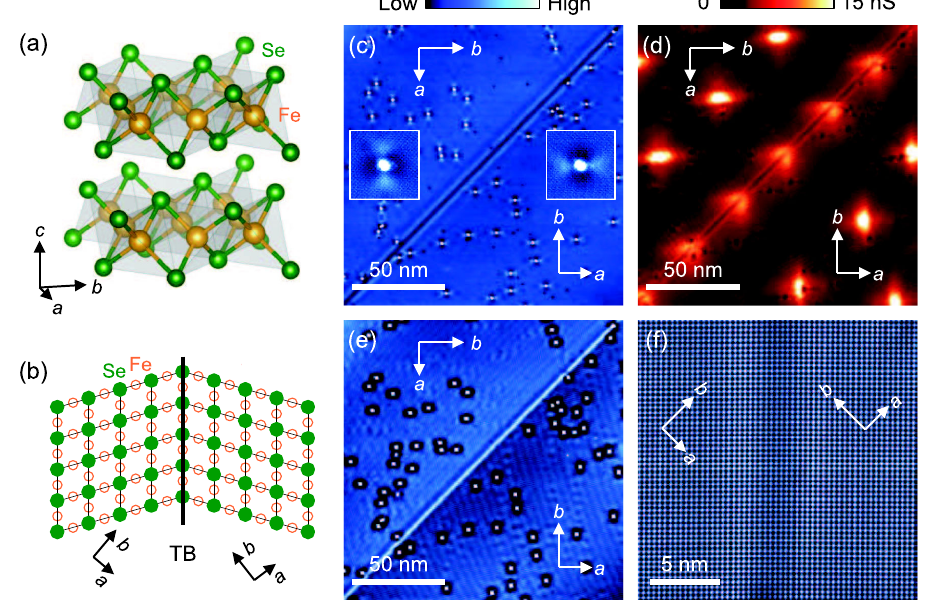
FIG. 1. (a) Crystal structure of FeSe visualized using the VESTA program [18]. (b) Schematic top view of the atomic arrangement near the TB of FeSe (not in scale). Green filled circles and orange open circles denote topmost Se and Fe atoms, respectively. Se atoms beneath the Fe layer are not shown. (c) A constant-current STM image of the cleaved (001) surface of FeSe at 1.5 K showing the TB running from bottom left to top right. Crystallographic axes parallel to the Fe-Fe direction are shown by white arrows ( b > a ). The two insets show a magnified image of the defect ( 8 . 8 × 8 . 8 nm 2 ) in the upper-left or lower-right domain. Note that the pattern is rotated by π = 2 between the two domains. The setup conditions for imaging are V 95 mV and I 10 pA. (d) Zero-bias conductance image s ¼ þ t ¼ 10 mV and g ð r ; E ¼ 0 Þ at 1.5 K showing vortices. A magnetic field of 1 T is applied along the c axis. The tip is stabilized at V s ¼ þ 100 pA. A bias modulation amplitude V 0 . 21 mV I is used for spectroscopy. (e) A low-bias STM image at 1.5 K taken with t ¼ mod ¼ rms 20 mV and I 10 pA. The field of view for (c) – (e) is the same. (f) An atomic-resolution STM image near the TB, which is V s ¼ þ t ¼ 95 mV and I 100 running vertically in the center of the field of view. V s ¼ þ t ¼